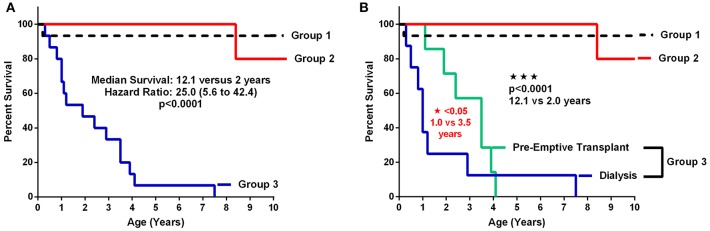
(A,B) Patient and renal survival curves according to Stage of CKD. (A) shows the survival curves of the 3 major subgroups comparing early stage and pre-dialysis CKD (Groups 1 and 2) vs. ESRD (Group 3). (B) shows the survival curves with the advanced CKD (Group 3) divided into the dialysis patients vs. those who were managed conservatively without dialysis until pre-emptive transplantation (TX: transplantation).